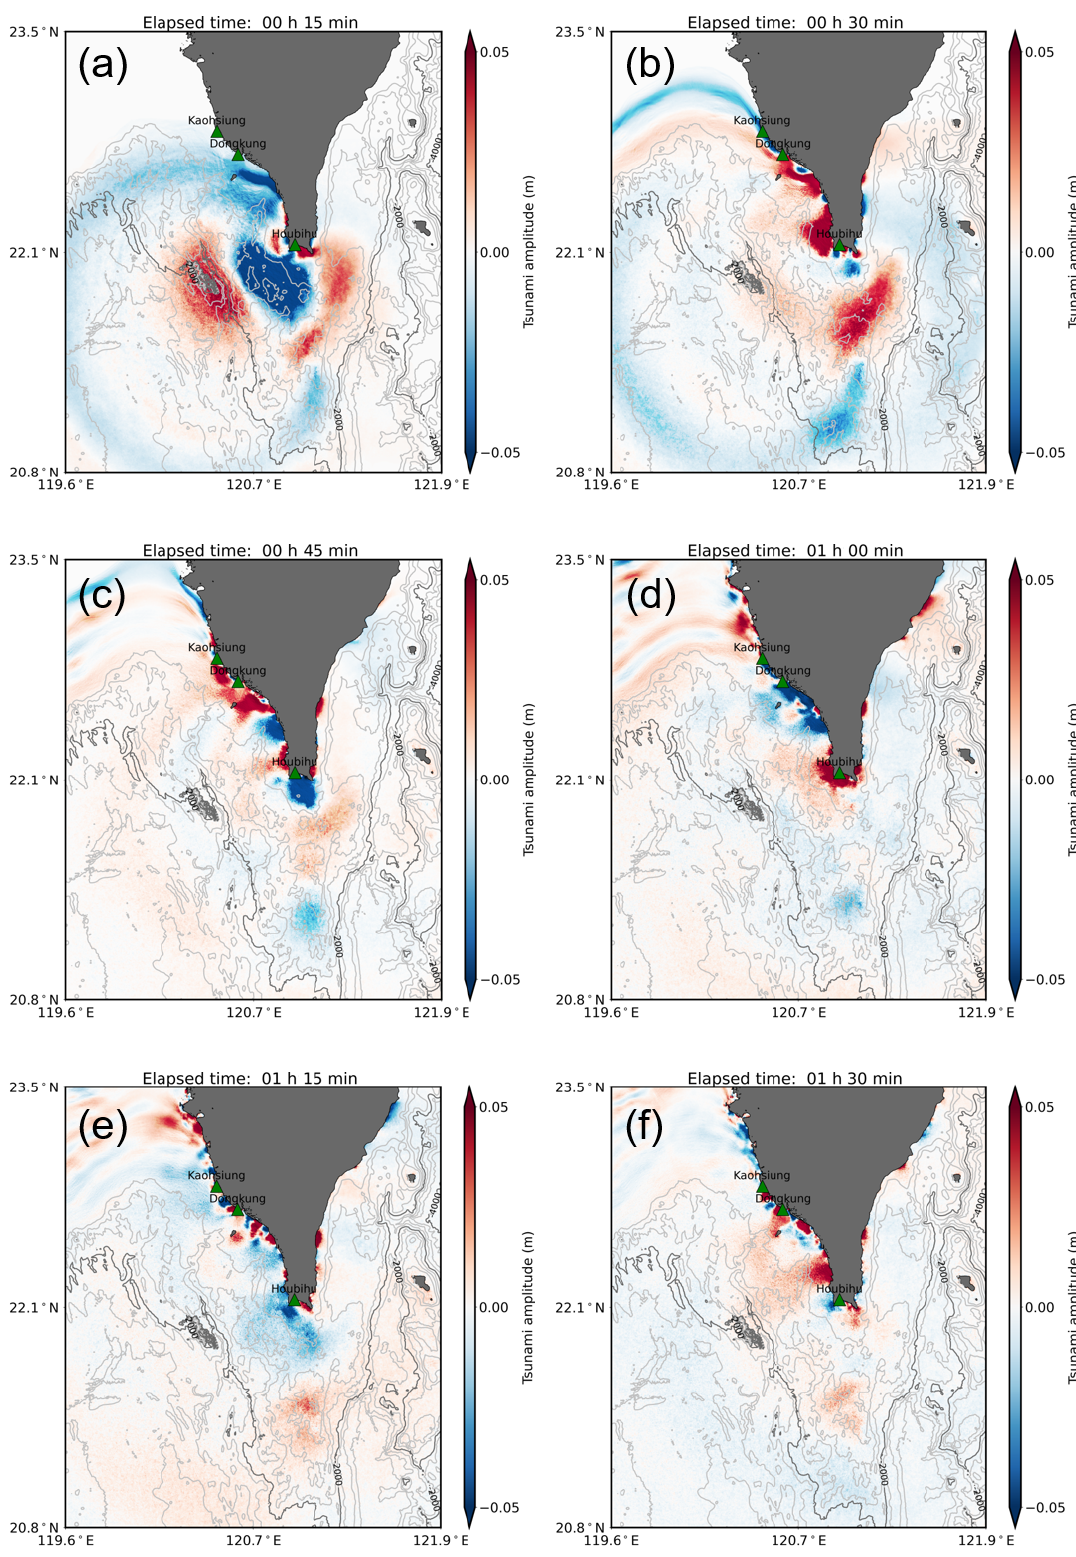
Figure 21. Tsunami propagation snapshots from the numerical experiment MS. The tide gauge stations are plotted in green triangles. The bathymetry contour is